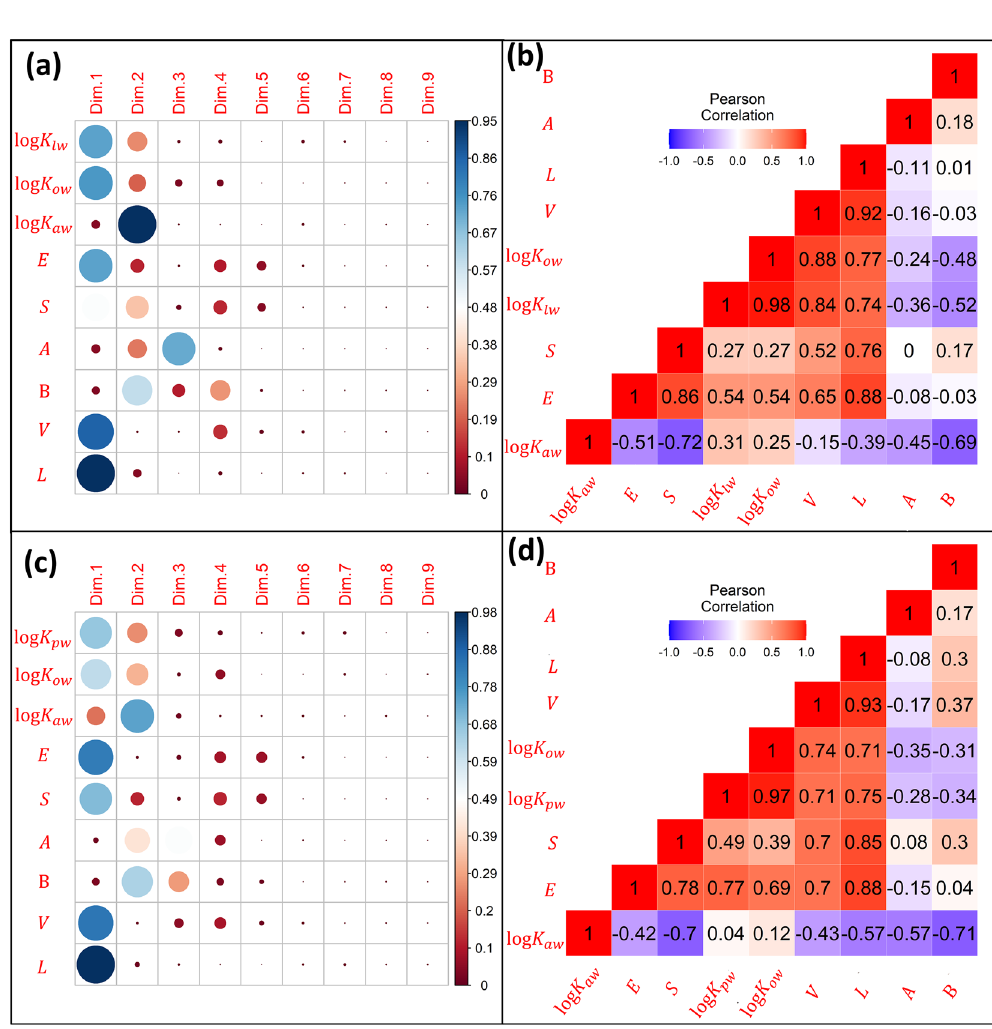
Figure 1. Dimensionality analyses on the calibration datasets for tp-LFER models of logK lw and logK pw . The upper panels show the results obtained by (a) the Principal Component Analysis (PCA) and (b) Pearson Correlation Analysis performed on 305 × 9 matrix, [logK lw , E, S, A, B, V, L, logK ow , logK aw ]. The lower panels show the results of ( c ) PCA and ( d ) Pearson Correlation Analysis on 131 × 9 matrix, [logK pw , E, S, A, B, V, L, logK ow , logK aw ]. For left panels ( a ) and ( c ), the color intensity and size of the circle are proportional to the quality of presentation of a variable in each principal dimension (dim). For panels ( b ) and ( d ): each square contains the value of correlation coefficient for each pair of variables. Blue and red colors show negative and positive correlations between the pairs,